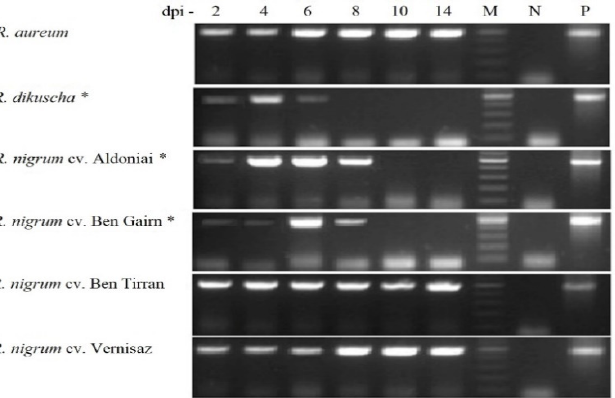
Figure 5. PCR product of the BRV (481 bp) in Ribes microshoots after 2–14 dpi. M—gene ruler 100–500 bp; N—negative controls were virus free plants; P—positive control was inoculum; *—BRV-resistant genotypes. In vitro plants of R. dikuscha and R. nigrum cvs. Aldoniai or Ben Gairn remained symptom-free in the post-inoculation period. Clearly, symptoms of response to biotic stress were visible on R. aureum microplants after 6 dpi (Figure 6). The leaves changed their colour, and the clear synthesis of the stress-characteristic phenolic compounds became visible.